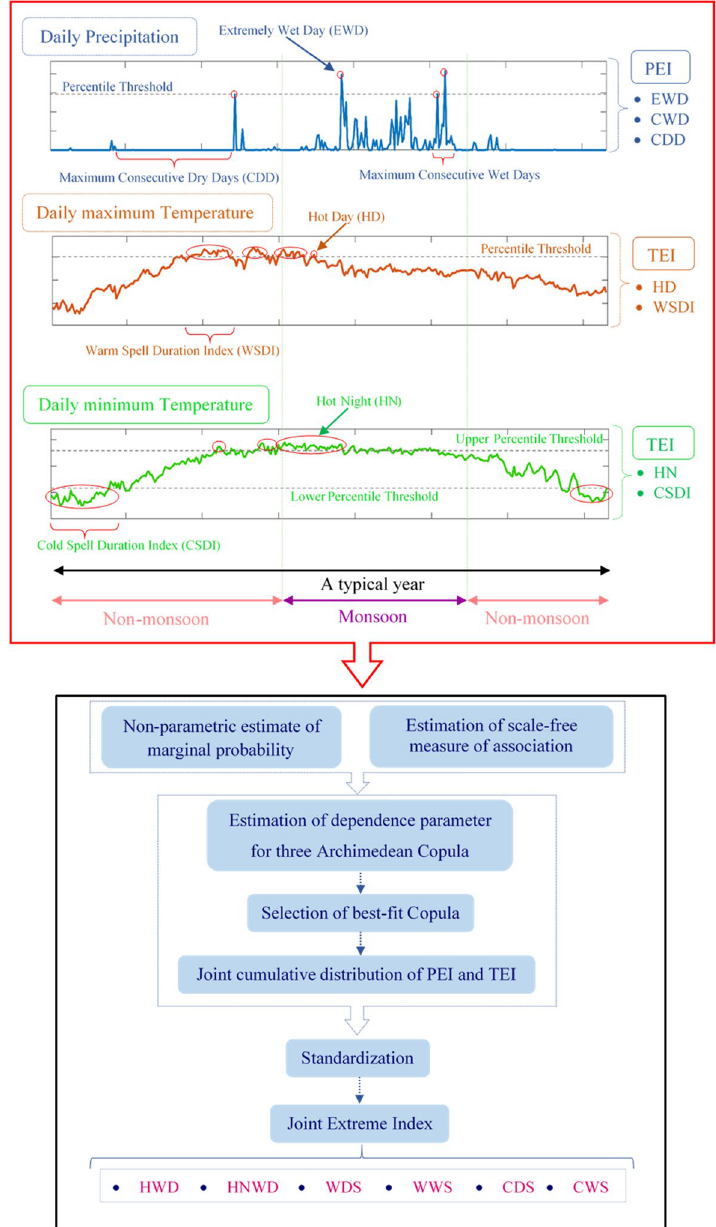
Figure 8. A schematic outline of methodology to develop the Joint Extreme Indices